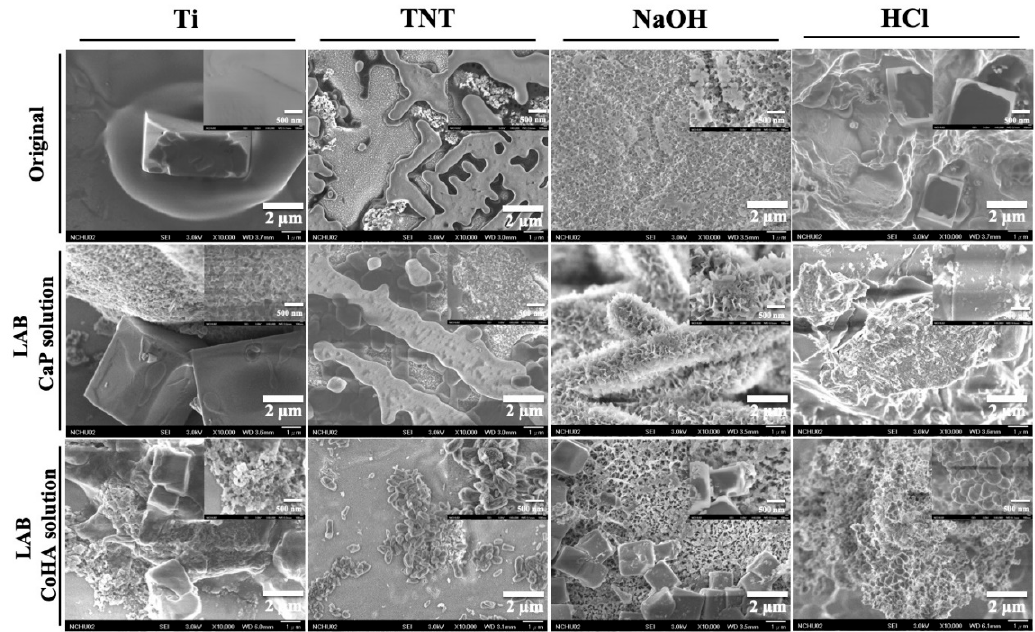
Figure 7. The surface topography of the LAB-treated samples after soaking in simulated body fluid (SBF) for seven days by FE-SEM. Table 3. Surface element analysis of the LAB-treated samples after soaking in SBF for seven days by